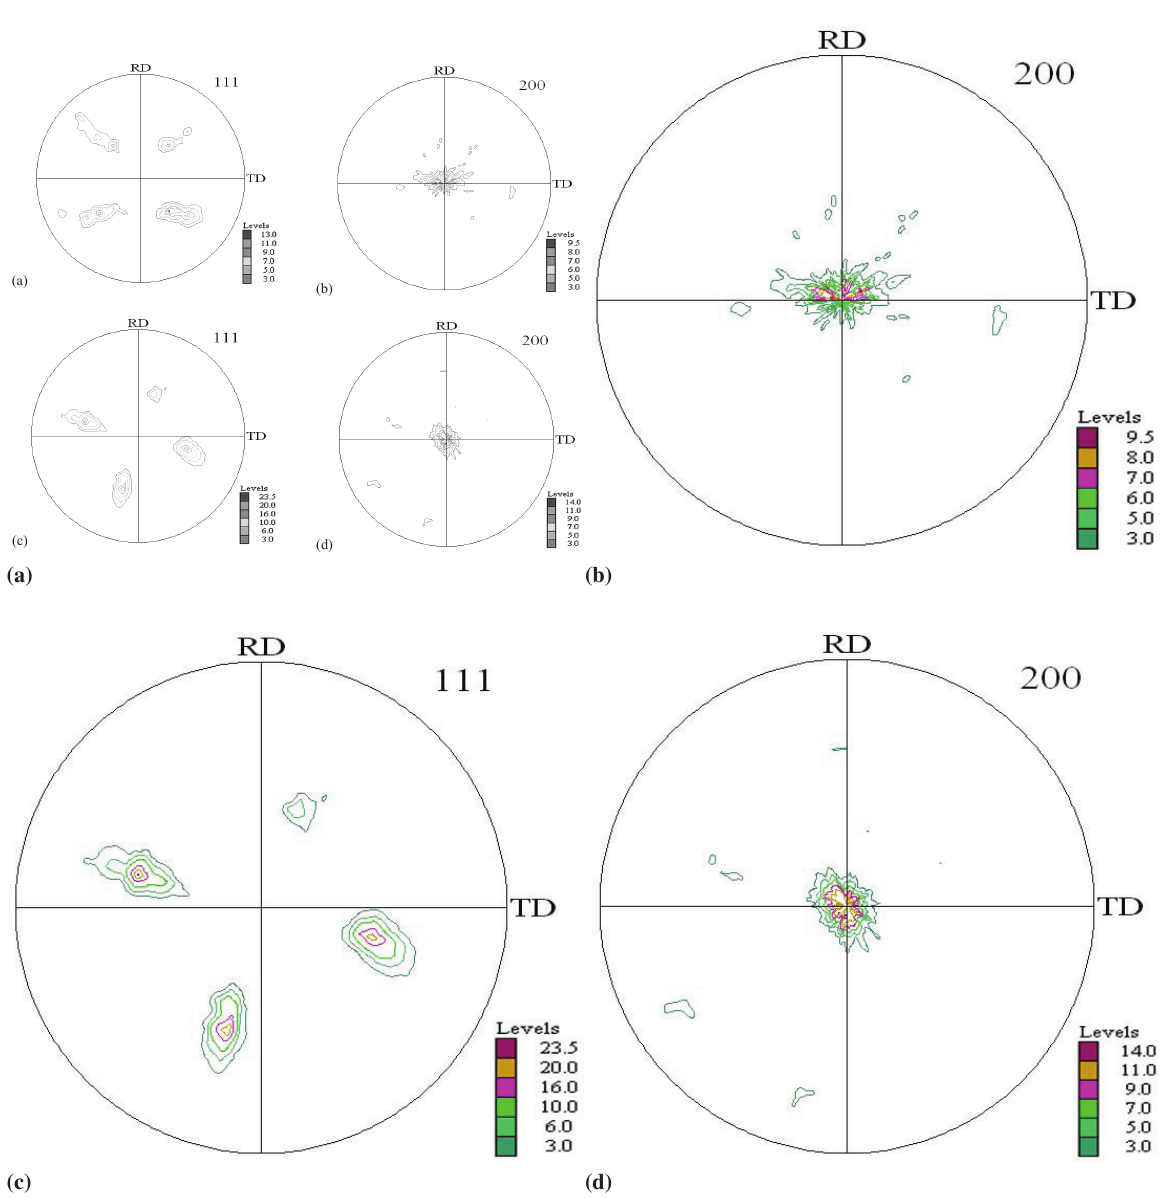
Figure 6. Pole figures for the 7YSZ coating deposited on a rotated sample with substrate pre-heating temperature of 1050°C: (a–b) 10 rpm and (c–d) 20